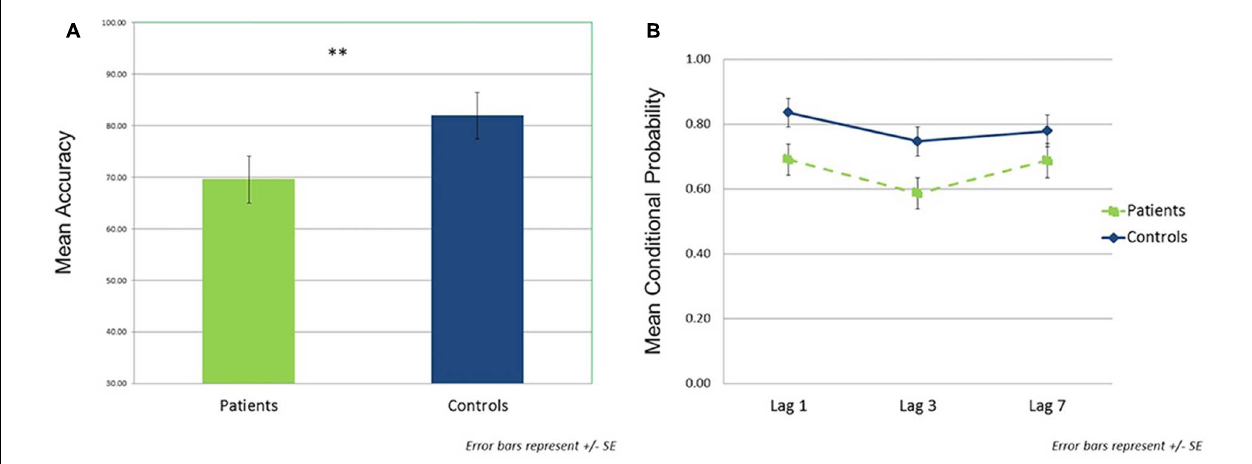
FIGURE 3 | Behavioral performance data. (A) Single target task performance (mean accuracy) by group. (B) Dual target task performance by group as a function of lag. Assessed using the probability of correct T2 identification given correct T1 identification (conditional probability). ∗∗ p < 0.01.